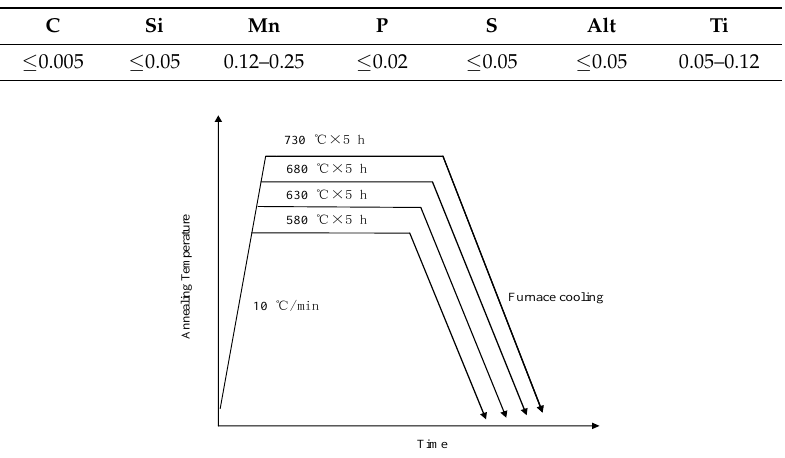
Figure 1. Schematic of the batch annealing process of ultra ‐ low carbon enamel steel.